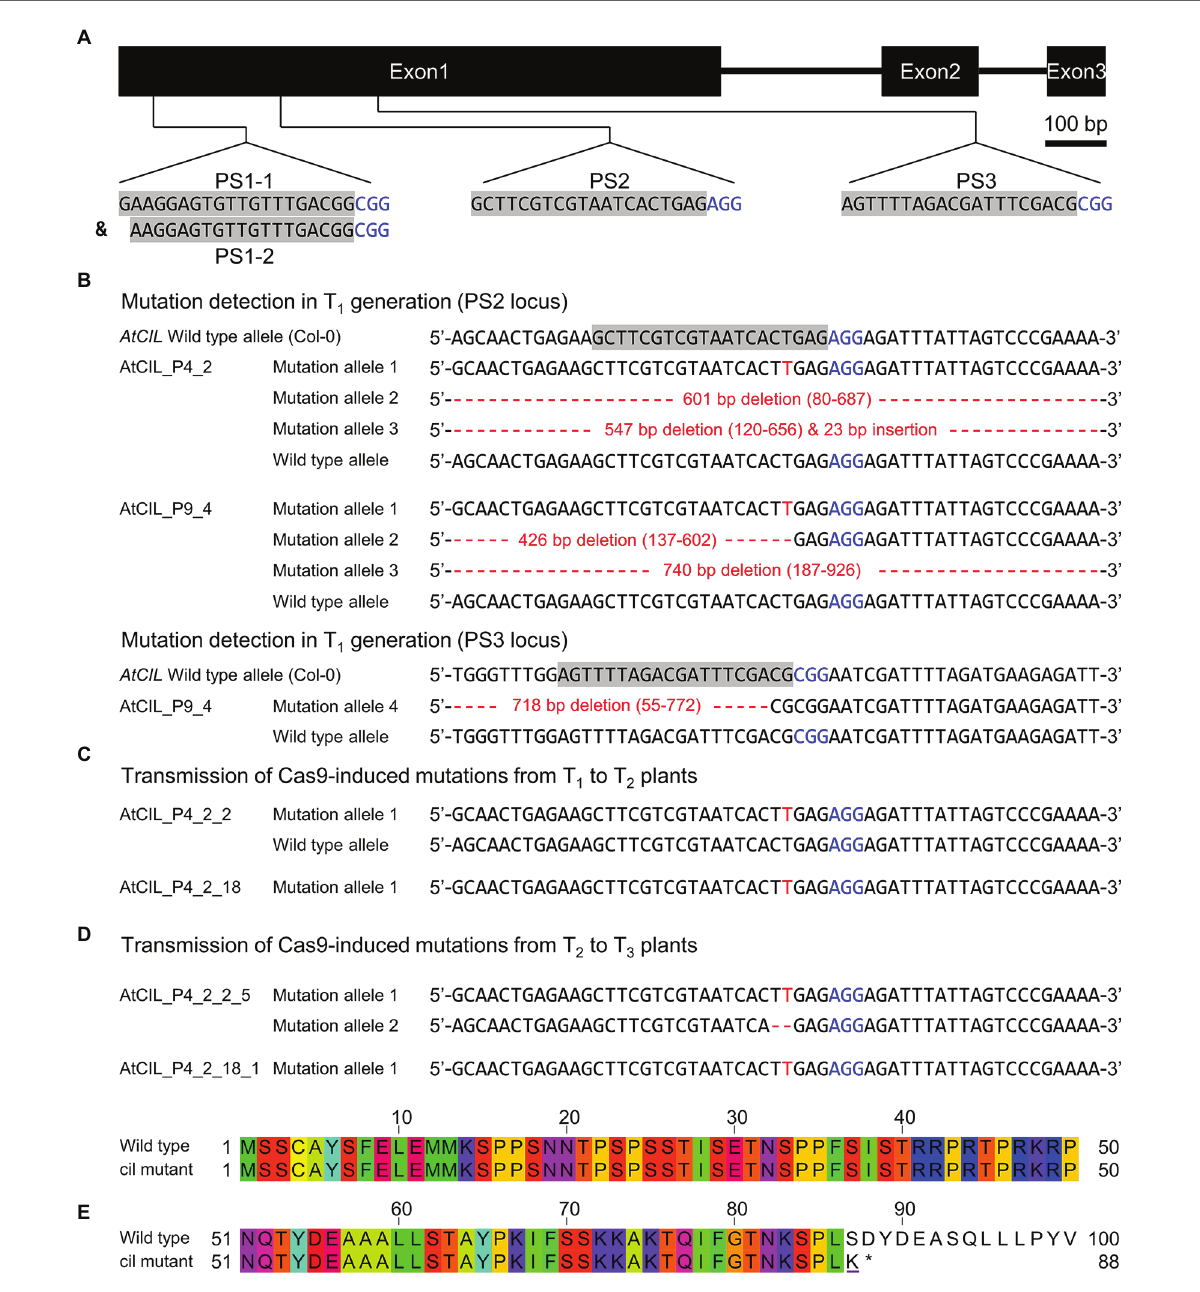
FIGURE 2 | Site-directed mutagenesis of the cil gene by CRISPR. (A) Structure of the cil gene and guide RNA selection. The protospacer sequences are indicated by gray background and the protospacer adjacent motifs are highlighted by blue color. (B) Mutation detection in T 1 plants. Two chimeric plants, AtCIL_P4_2 and AtCIL_P9_4, carrying mutations at either or both PS2 and PS3 target loci. Large deletions/insertions are represented by red dashes and small insertions by red letters. Coordinates in parentheses indicate the region of deletion. The adenine in the start codon of the cil sequence is counted as +1. (C) Inheritance of mutations in the T 2 generation. The heterozygous plant AtCIL_P4_2_2 and the homozygous plant AtCIL_P4_2_18 carry a one-nucleotide insertion 3 bp upstream of the protospacer adjacent motif of the PS2 locus. (D) Inheritance of mutations in the T 3 generation. One biallelic mutant, AtCIL_P4_2_2_5, was identified. It carries a one-nucleotide insertion and a 2 bp deletion. The mutation of the T 2 plant AtCIL_P4_2_18 is stably transmitted from the T 2 to the T 3 generation. (E) Alignment of the deduced N-terminal protein sequences of wild type and cil . The altered amino acid of the mutant is underlined; an asterisk indicates the position of the immature stop